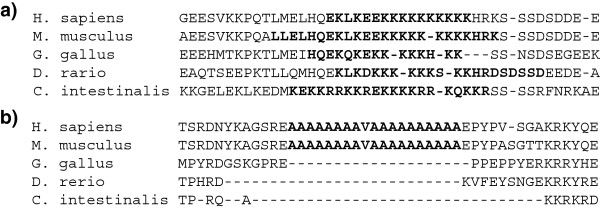
Conservation of low-complexity regions (LCRs) in chordate homologous protein families. LCRs are indicated in red. Only the region of the alignment containing the LCR is shown. a) Example of conserved chordate LCR enriched in lysines. Corresponds to methionyl aminopeptidase 2 (Ensembl Protein Identifier ENSP00000325312 in humans). b) Example of mammalian-specific LCR enriched in alanines. Corresponds to alkylation repair 5 (Ensembl Protein Identifier ENSP00000261650 in humans).